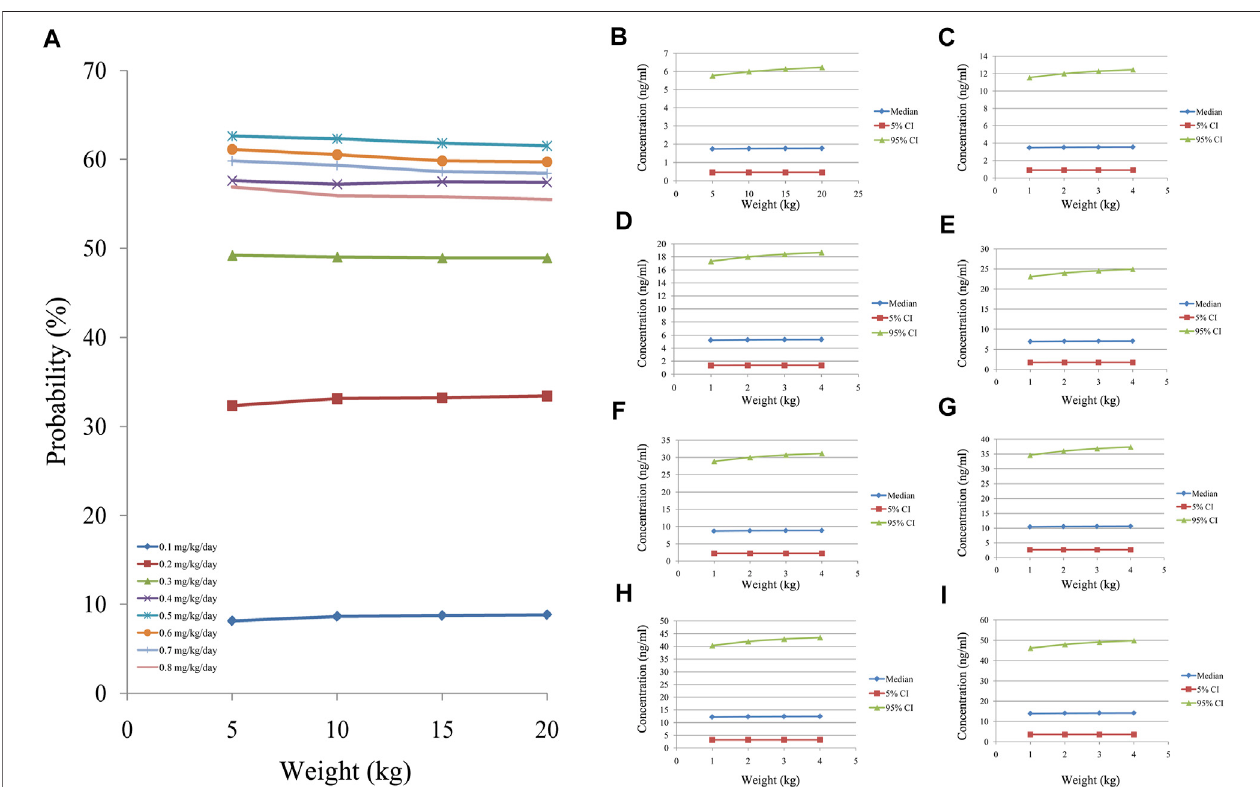
FIGURE 6 | Probability of tacrolimus concentrations in CD children undergoing HSCT with posaconazole. (A) Probability of reaching tacrolimus concentrations (5 – 20 ng/ml). (B) 0.1 mg/kg/day tacrolimus-simulated concentrations. (C) 0.2 mg/kg/day tacrolimus-simulated concentrations. (D) 0.3 mg/kg/day tacrolimus- simulated concentrations. (E) 0.4 mg/kg/day tacrolimus-simulated concentrations. (F) 0.5 mg/kg/day tacrolimus-simulated concentrations. (G) 0.6 mg/kg/day tacrolimus-simulated concentrations. (H) 0.7 mg/kg/day tacrolimus-simulated concentrations. (I) 0.8 mg/kg/day tacrolimus-simulated concentrations. Median, 5% CI; 95% CI were median value, 5% and 95% con fi dence interval of 1000 times